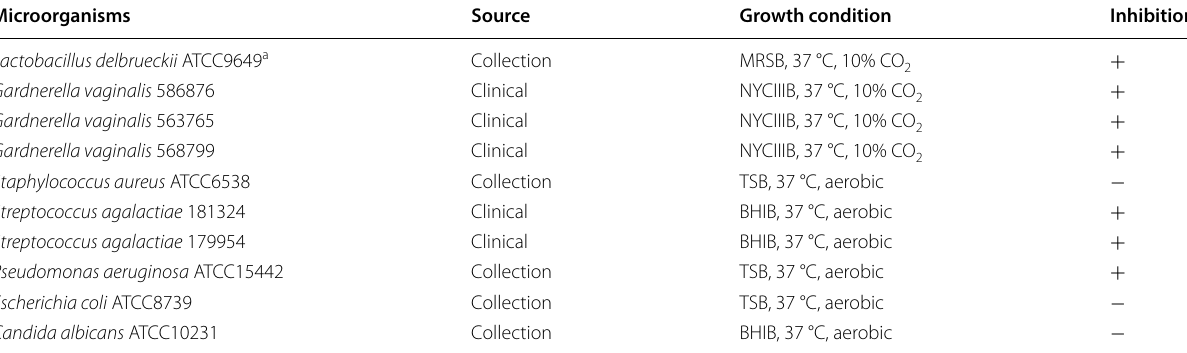
a Indicator microorganism